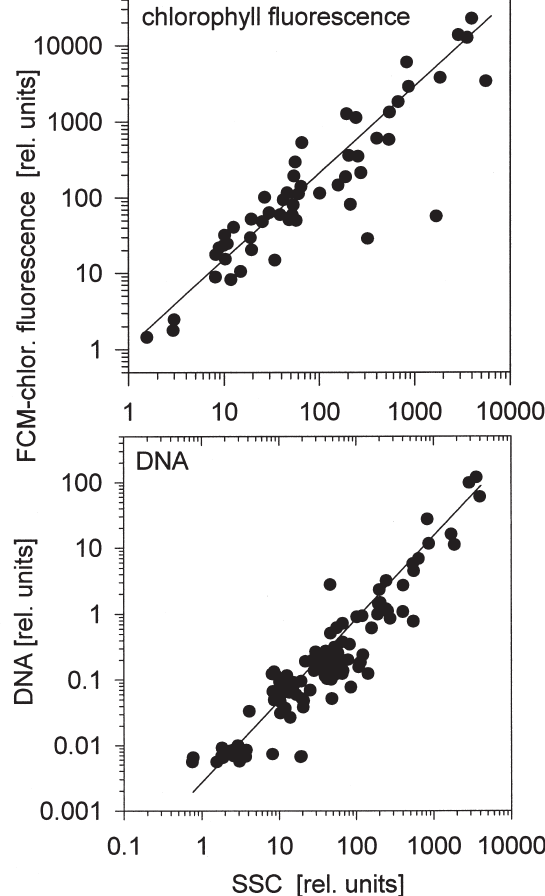
FLOW CYTOMETRY ANALYSIS OF PHYTOPLANKTON 123